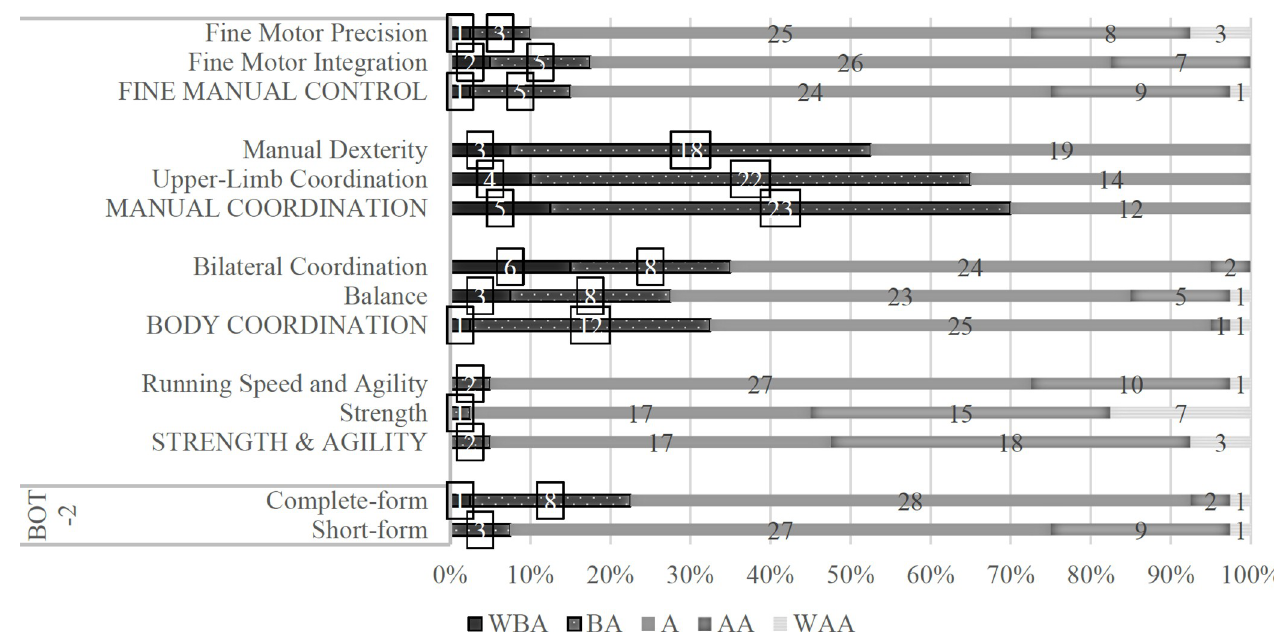
Fig 2. Distribution of BOT-2 results in preschool children with strabismus. WBA: Well-Below Average (Scale Score � 5; Standard Score � 30; %ile Rank � 2); BA: Below Average (10 � Scale Score � 6; 40 � Standard Score � 31; 17 � %ile Rank � 3); A: Average (19 � Scale Score � 11; 59 � Standard Score � 41; 83 � %ile Rank � 18); AA: Above Average (24 � Scale Score � 20; 69 � Standard Score � 60; 97 � %ile Rank � 84); WAA: Well-Above Average (Scale Score � 25; Standard Score � 70; %ile Rank � 98).